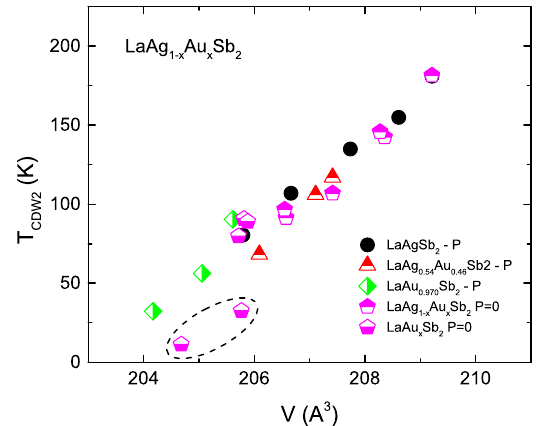
Figure 12. CDW2 transition temperature for LaAg 1 − x Au x Sb 2 and LaAu x Sb 2 [17] at ambient and high pressure as a function of the unit cell volume, V . Encircled points discussed in the